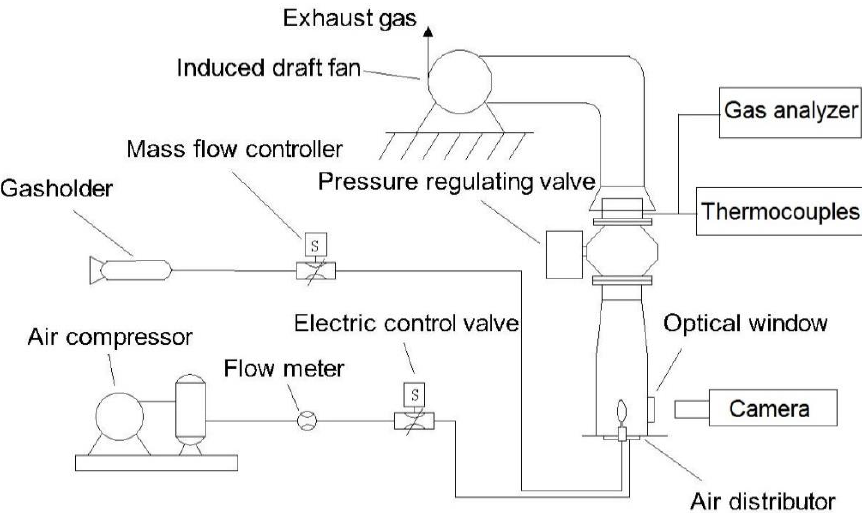
Figure 2. The schematic diagram of high-pressure combustion test rig.